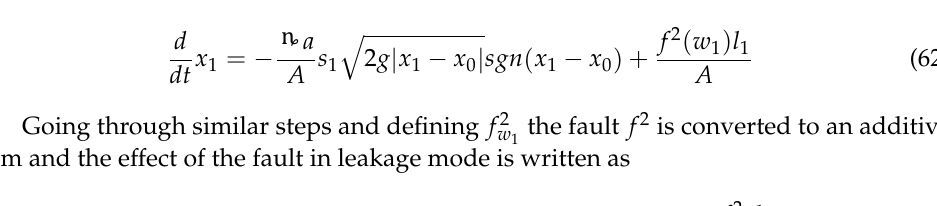
Figure 1. Three-pond hydraulic system.